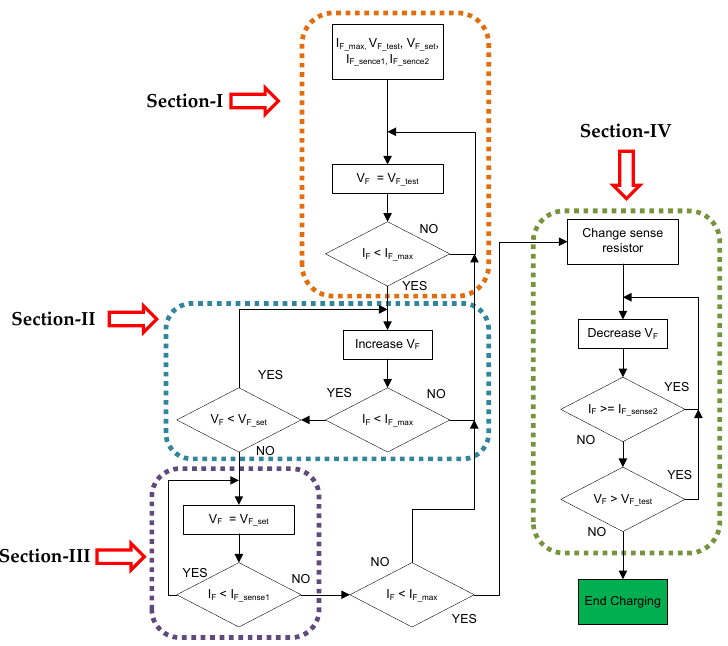
Figure 5. Flow chart of the control algorithm for wireless charging.